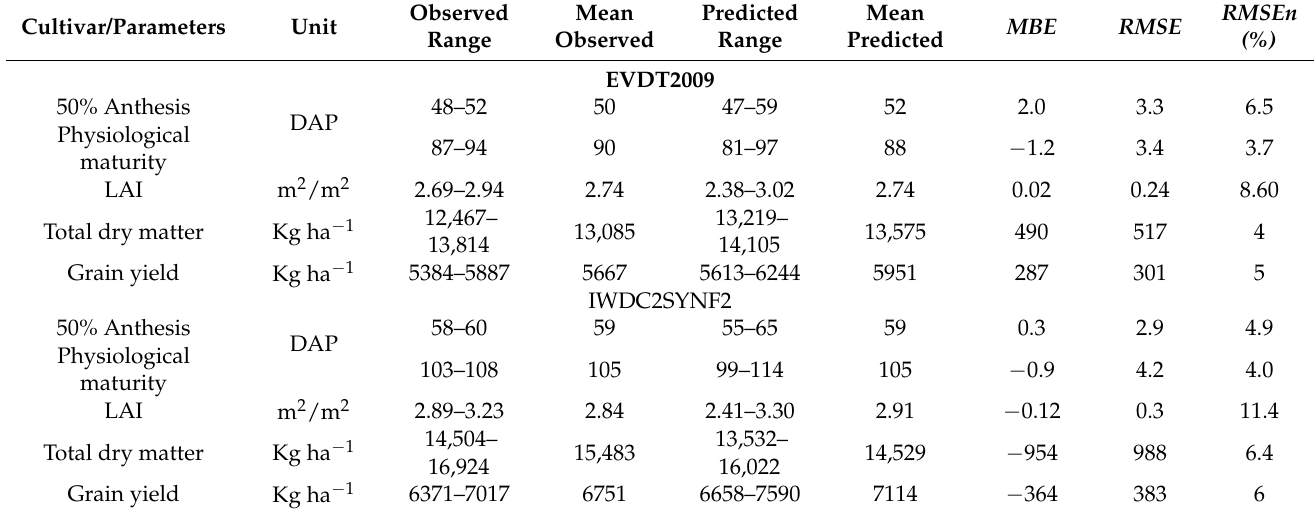
Table 3. Comparison of observed and simulated parameters for phenological development, leaf area index (LAI), total dry matter (TDM) and grain yield, after model